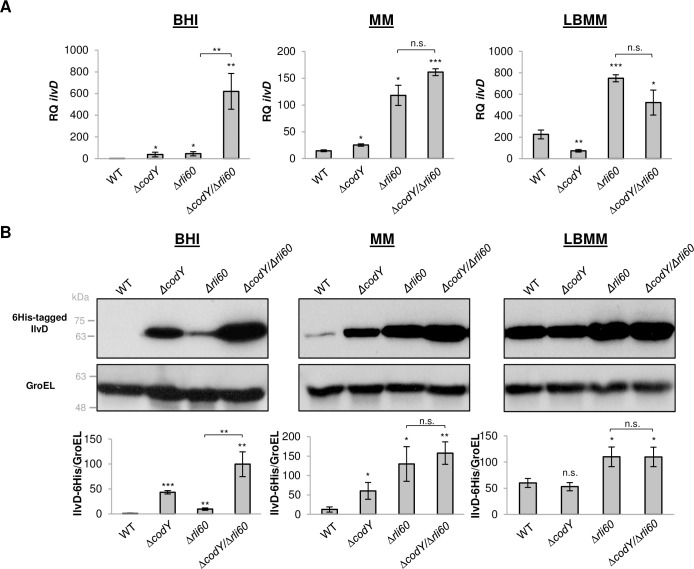
Both Rli60 and CodY negatively regulate the BCAA biosynthesis pathway.(A) qRT-PCR analysis of ilvD transcription level in WT Lm, ΔcodY, Δrli60 and ΔcodY/Δrli60 bacteria grown in BHI, MM and LBMM. ilvD mRNA levels were normalized to rpoD mRNA and are represented as relative quantity (RQ), relative to ilvD mRNA level in WT bacteria grown in BHI. The data represent 3 biological replicates (N = 3). Error bars indicate standard deviation. Asterisks represent P-values (* = P<0.05, ** = P<0.01, *** = P<0.001, n.s. = non-significant), calculated using Student’s t-test. P-values represent a comparison to the respective WT sample, unless indicated otherwise. (B) Western blot analysis of 6His-tagged IlvD protein in WT Lm, ΔcodY, Δrli60 and ΔcodY/Δrli60 bacteria grown in BHI, MM and LBMM media. Anti-His antibody was used to probe the 6His-tagged IlvD. Detection of GroEL was used as a loading control. A representative blot is presented in the upper panel and densitometry analyses of 3 independent experiments are shown in the lower panel. IlvD-6His protein levels are relative to protein level in WT bacteria grown in BHI. Protein levels were normalized to GroEL protein. The data represent 3 biological replicates (N = 3). Error bars indicate standard deviation. Asterisks represent P-values (* = P<0.05, ** = P<0.01, *** = P<0.001, n.s. = non-significant) calculated by Student's t-test. P-values represent a comparison to the respective WT sample, unless indicated otherwise.